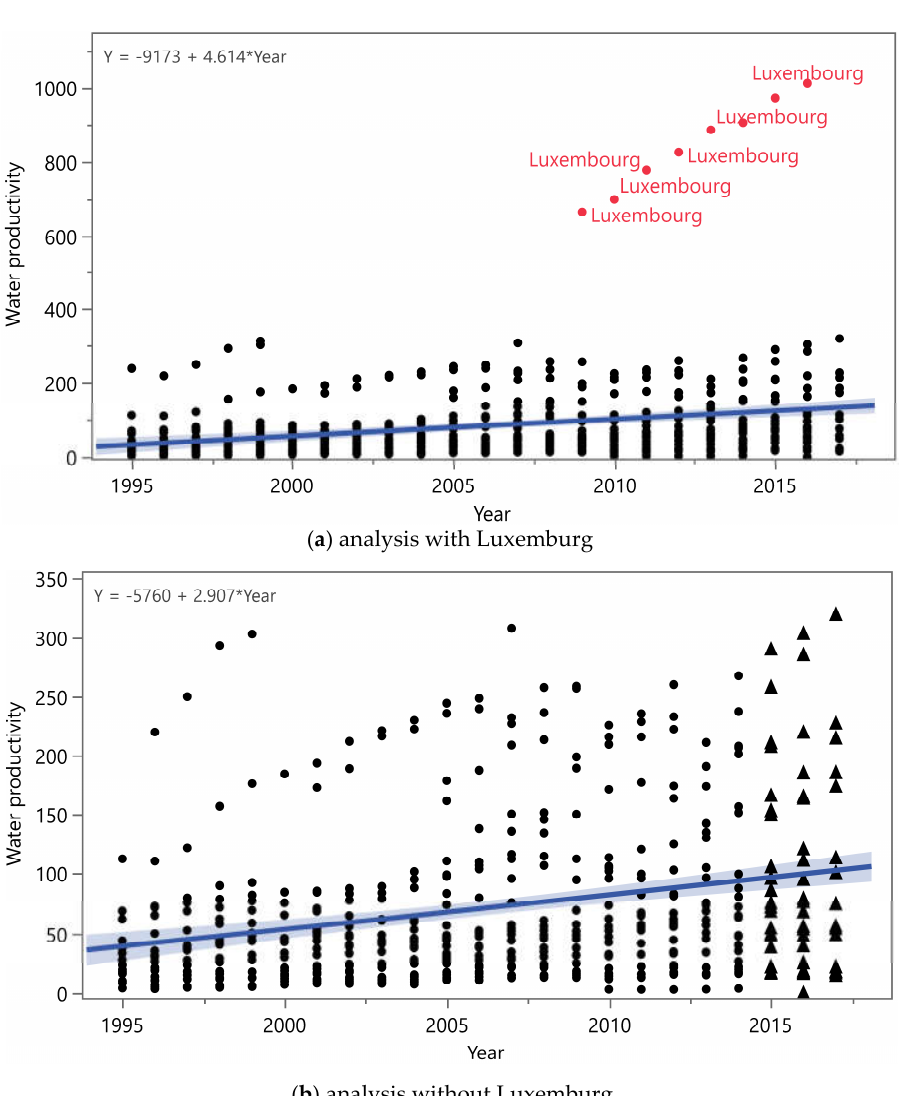
Figure 5. Water productivity (PPS/m 3 ) in EU member states in 1994–2017